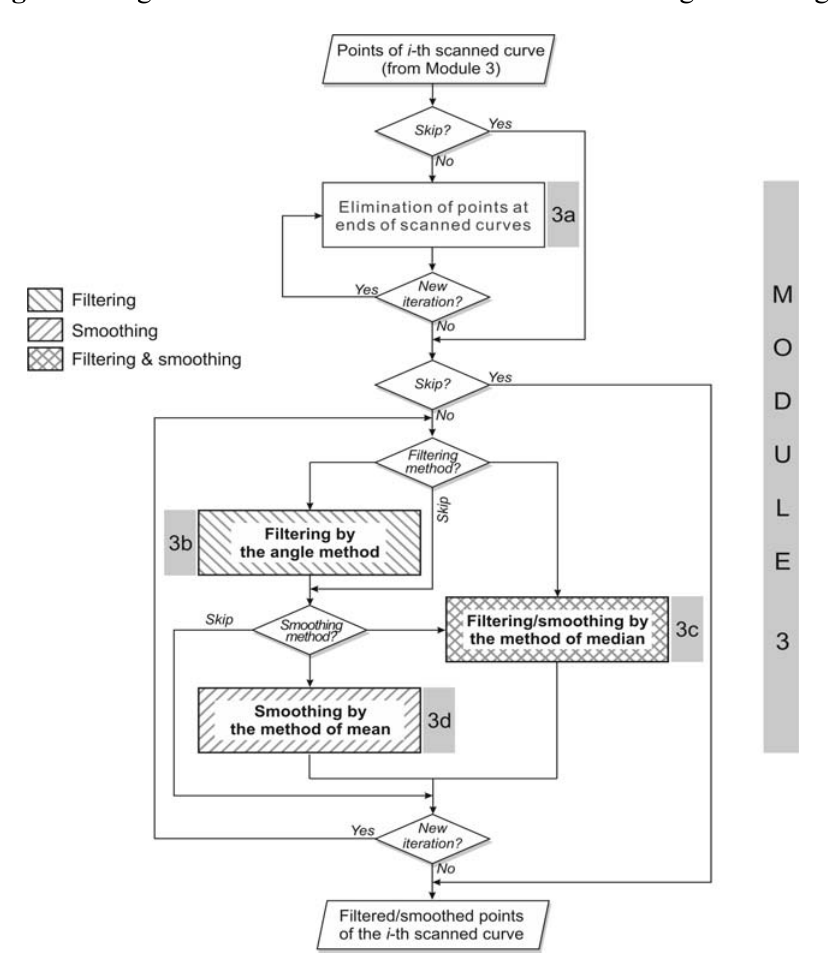
Figure 5. Algorithm of module for cross-sectional